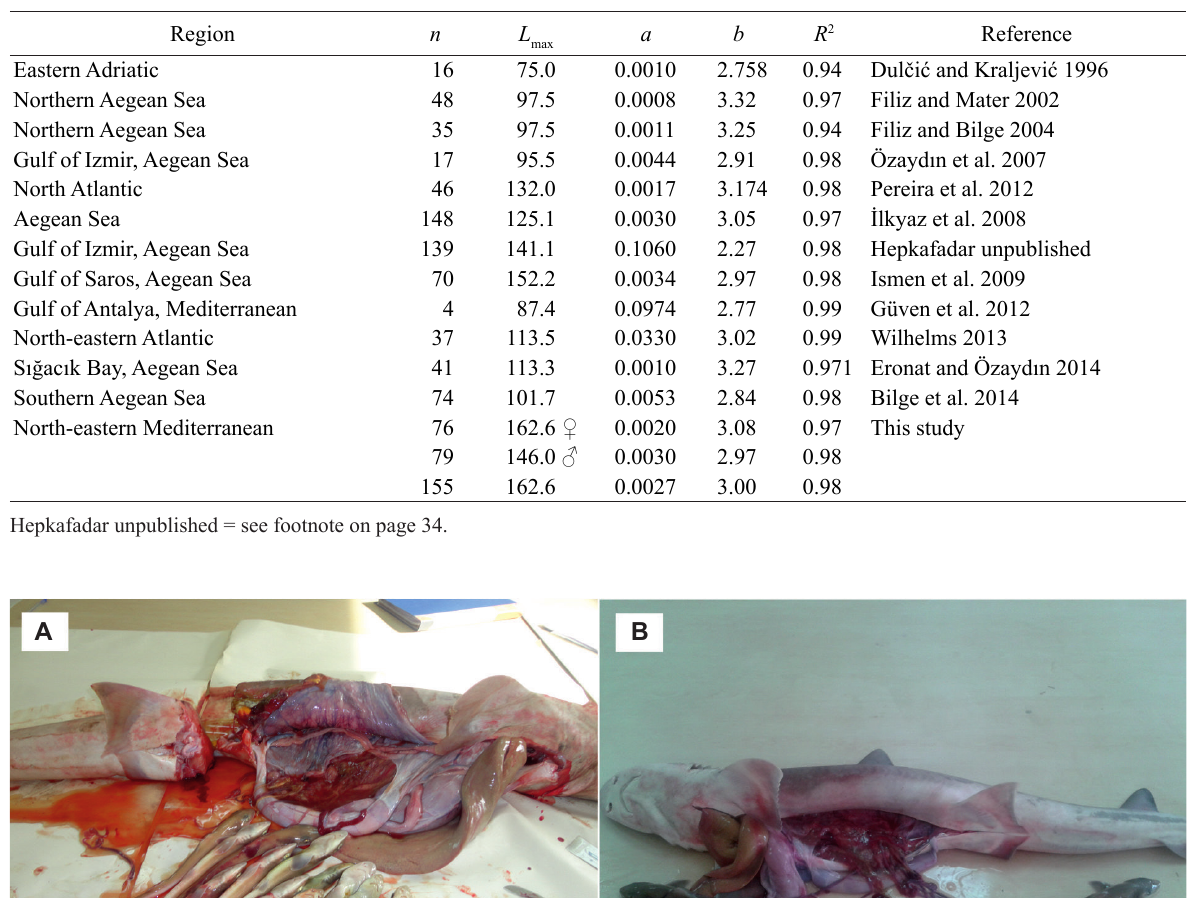
Comparison of total length–weight relations of Mustelus mustelus in various regions